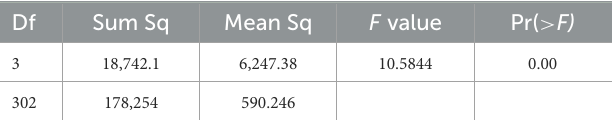
TABLE 4 ANOVA between SMAS scores and time of daily use of social media